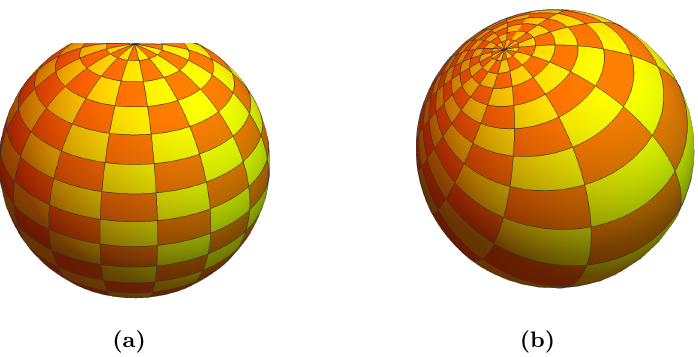
Figure 3. An example of a Lorentz transformation on the celestial sphere. The operator exp − iM +2 transforms (a) to